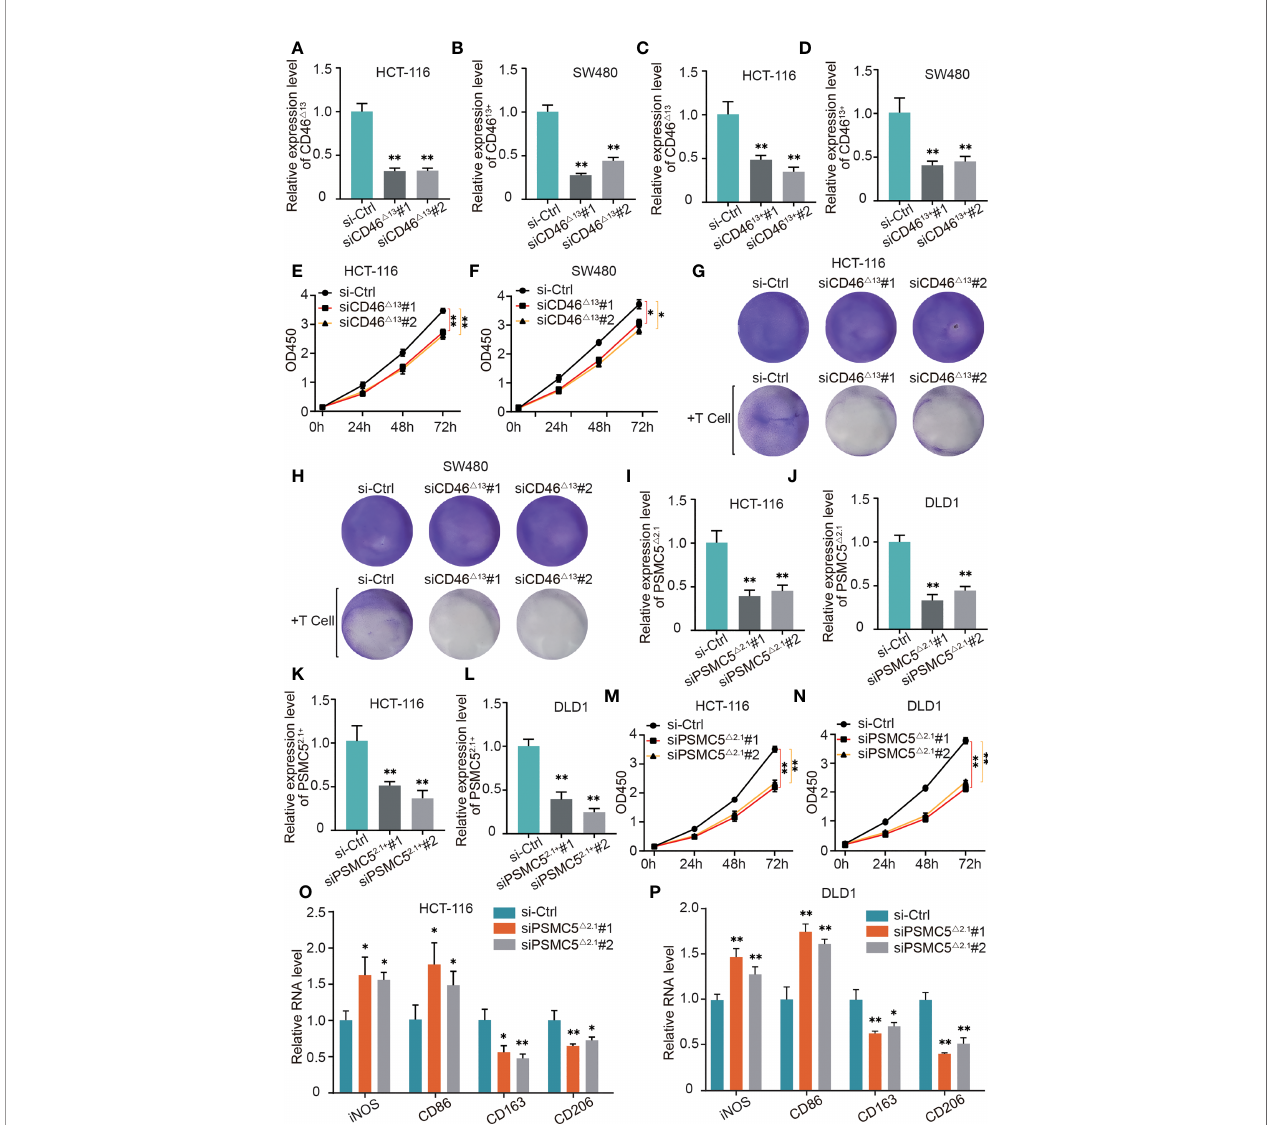
FIGURE 10 | The role of OS-ASEs with immune signatures in colon cancer. (A – D) Relative expression levels of CD46 △ 13 and CD46 13+ after transfection with siRNA in HCT116 and SW480 cells. (E, F) The proliferation ability of HT116 and LoVo cells after silencing CD46 △ 13 expression. (G, H) T cell-mediated tumour cell killing of HT116 and LoVo cells treated with si-CD46 △ 13 . Activated T cells and colon cancer cells were cocultured in 6-well plates for 4 days, and crystal violet staining showed the surviving tumour cells. (I – L) Relative expression levels of PSMC5 △ 2.1 and PSMC5 2.1+ after transfection with siRNA in HCT116 and DLD1 cells. (M, N) The proliferation ability of HT116 and LoVo cells after silencing PSMC5 △ 2.1 expression. (O, P) After coculturing colon cancer cells with THP-1-derived macrophages for 48 h by Transwell assay, we detected the relative mRNA levels of iNOS, CD86, CD206 and CD163 by qRT – PCR (G) . *p < 0.05 and **p <